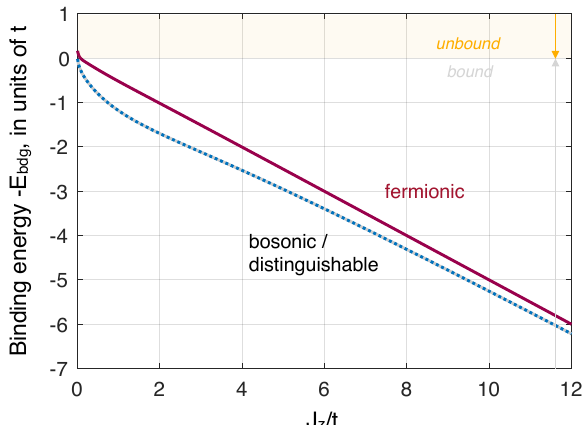
Figure 19: Negative binding energy − E / t and including larger values of J over J z ℓ = max